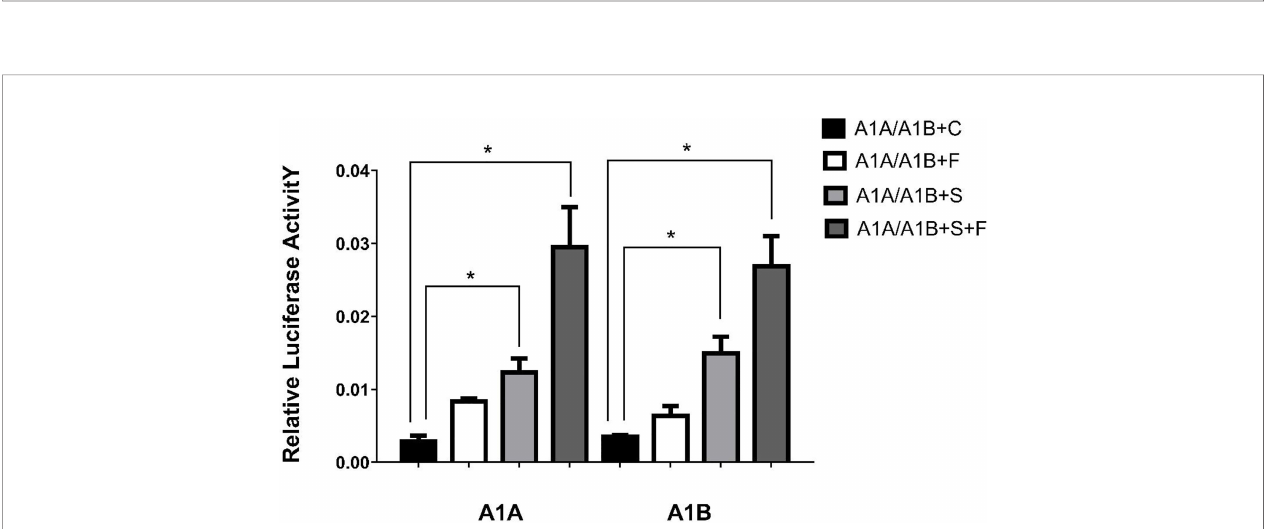
FIGURE 5 | Transcriptional activities of cyp19a1a and cyp19a1b promoters in COS-7 after 48h transfection. S meaned that only transcription factor SF-1 was added, F meaned that only transcription factor FOXL2 was added. S+F meaned that transcription factors SF-1 and FOXL2 were added at the same time. One-way ANOVA was performed on the data and expressed as mean ± standard deviation (n = 4). *There is a signi fi cant difference between the data.